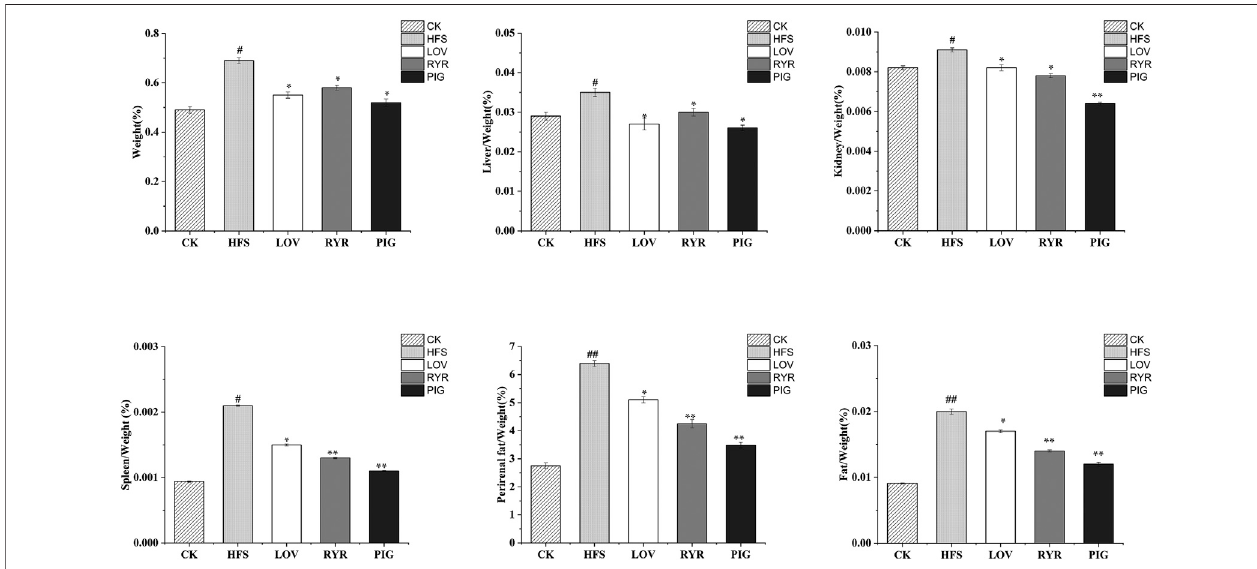
FIGURE 1 | Determination results of body mass and viscera quality of different groups of rats (n (cid:2) 8). Note: Compared with CK group, “ # ” means signi fi cant difference ( p < 0.05), “ ## ” means extremely signi fi cant difference ( p < 0.01); Compared with HFS group, “ * ” showed signi fi cant difference ( p < 0.05), and “ ** ” showed extremely signi fi cant difference ( p < 0.01), the same as